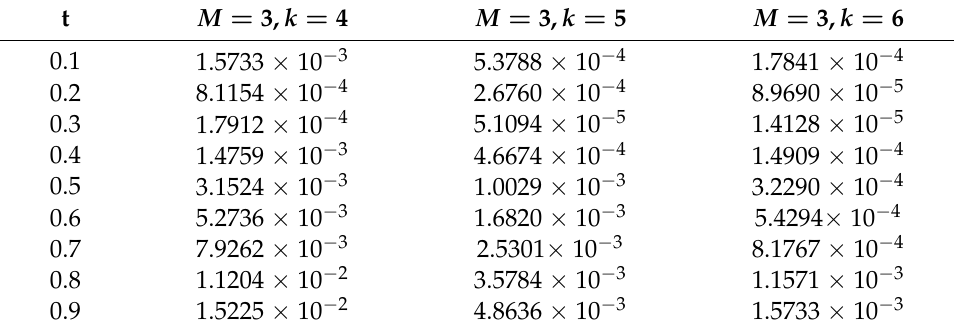
Table 1. Absolute error of y 1 ( t ) for M = 3 and k = 4,5,6 (Example 1).